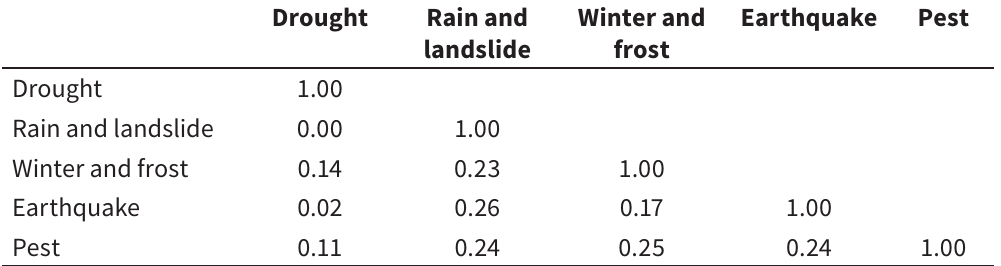
Drought Rain and